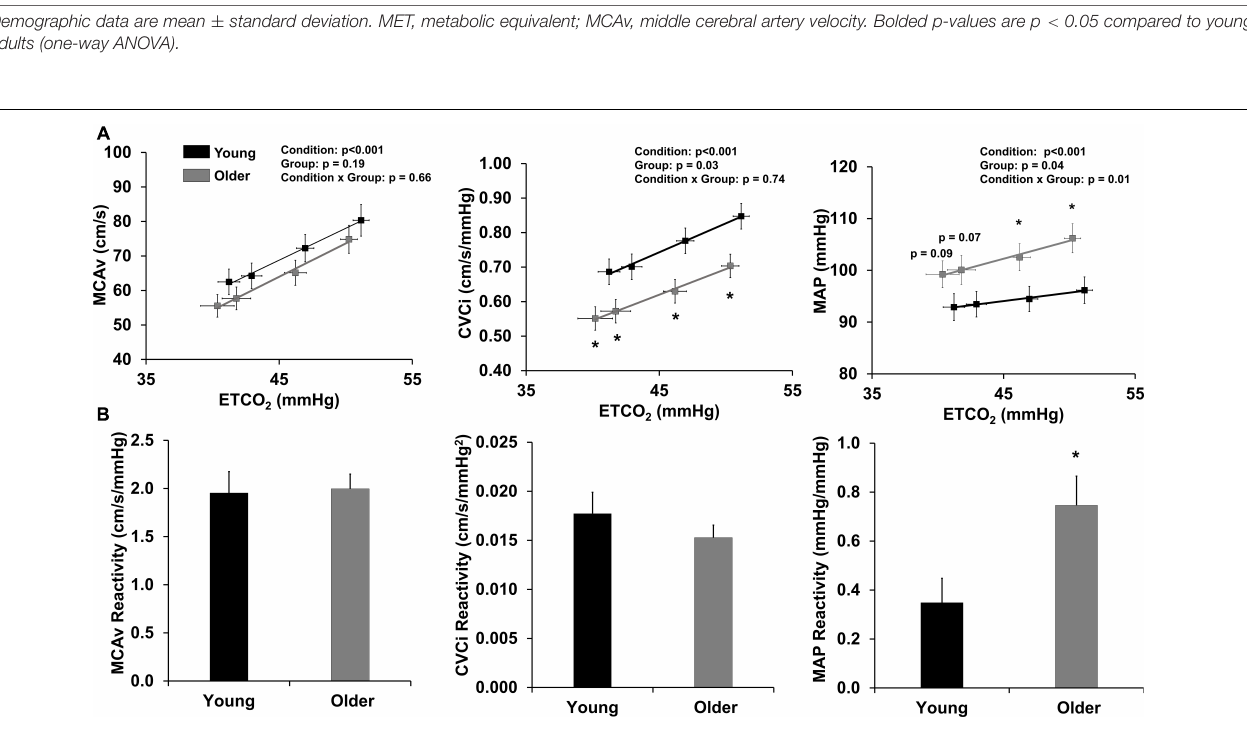
FIGURE 1 | Cerebrovascular reactivity to hypercapnia. (A) Relationship between end-tidal CO 2 (ETCO 2 ) and variables of interest: MCAv (left), CVCi (middle), and MAP (right) during hypercapnia. Data are mean ± standard error of the mean. CVCi = MCAv/MAP. ∗ p < 0.05 compared to young adults (two-way repeated measures ANOVA). (B) Reactivity slopes for MCAv (left), CVCi (middle), and MAP (right) during hypercapnia. Young adults are shown in black and older adults are shown in gray. Data are mean ± standard error of the mean. ∗ p < 0.05 compared to young adults (one-way ANOVA).